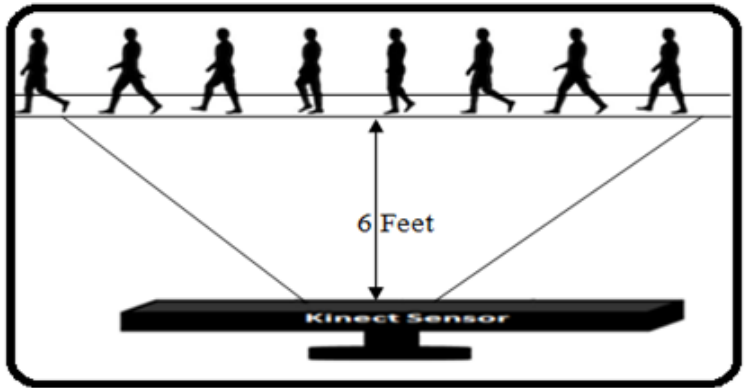
Figure 4. Experimental setup using MS